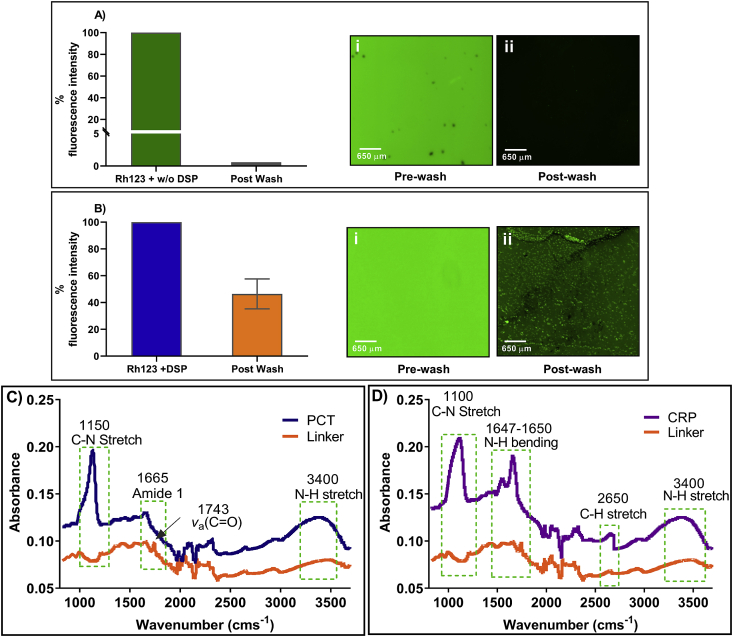
A) Fluorescence microscopy image of the sensor surface (i) pre-wash and (ii) post-wash without DSP cross-linker. (B) Fluorescence microscopy image of the modified sensor surface (i) pre-wash and (ii) post-wash with DSP cross-linker. (C) FTIR spectra of PCT and linker immobilized on ZnO modified surface. (D) FTIR spectra of CRP and linker immobilized on ZnO modified surface.